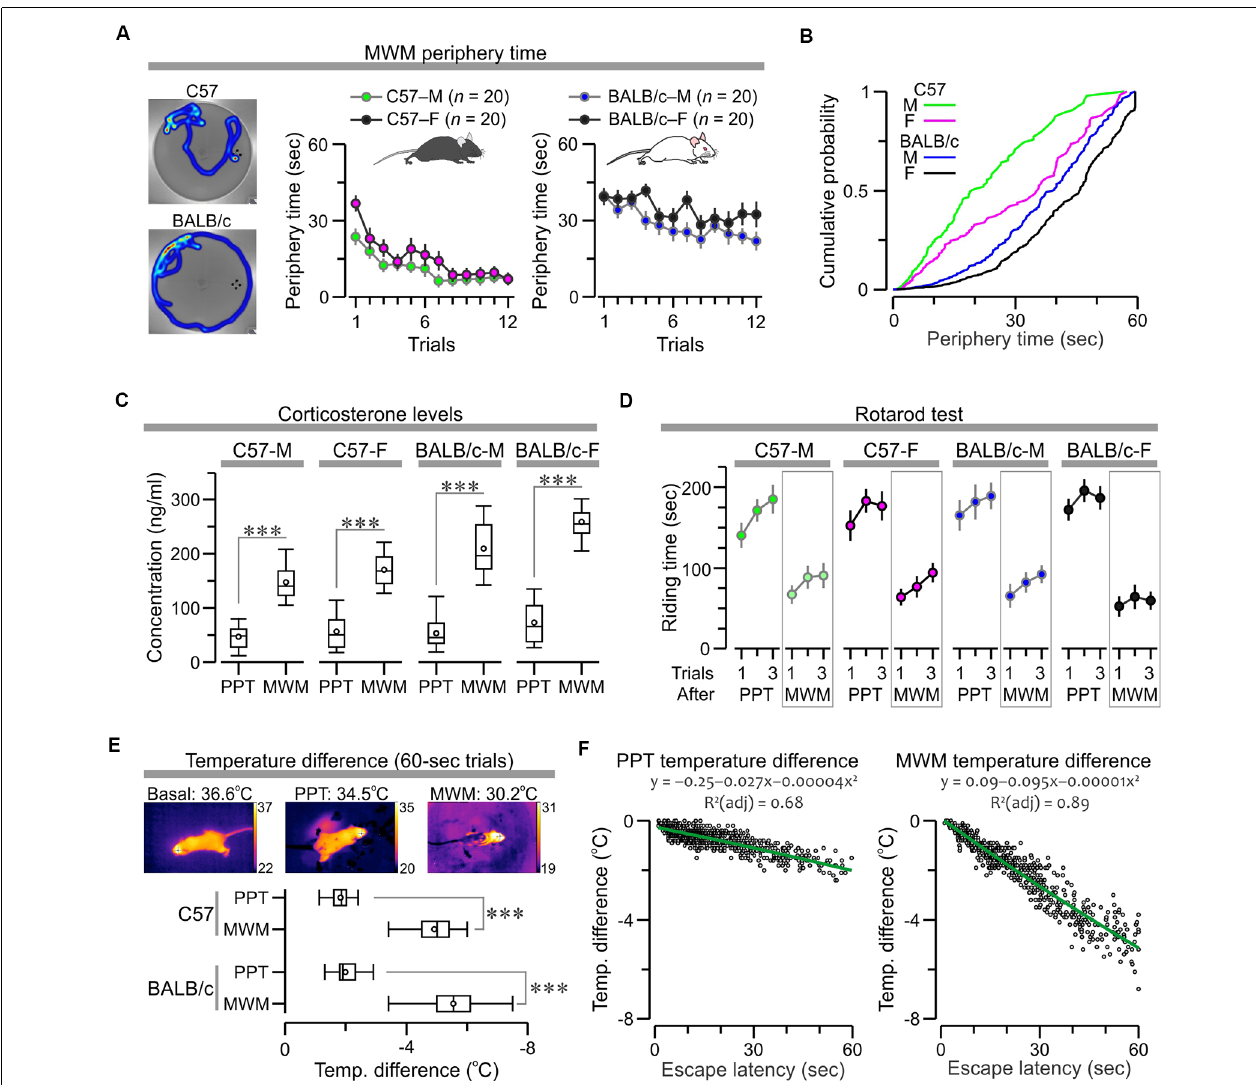
FIGURE 9 | Factors that influence performance in the PPT and MWM. (A) Left , representative heatmaps of mice swimming in the watermaze. Right , plots of periphery time (mean ± SEM) across trials show a clear decrease for C57 mice (C57 males, C57-M, F ( 1,11 ) = 5.79, P = 3.6 × 10 − 8 ; C57 females, C57-F, F ( 1,11 ) = 8.19, P = 7.1 × 10 − 12 , RMANOVA) and elevated values in all trials for BALB/c mice (BALB/c males, BALB/c-M, F ( 1,11 ) = 4.1, P = 1.57 × 10 − 5 ; BALB/c females, BALB/c-F, F